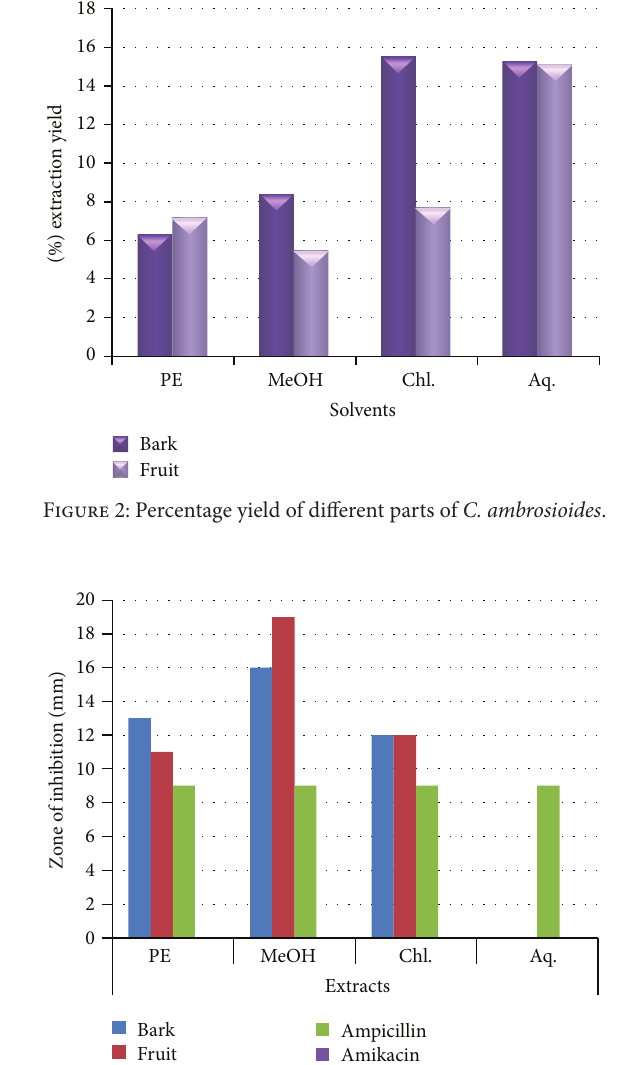
Figure 3: Zone of inhibition produced by different parts of ambro- sioides against E. coli